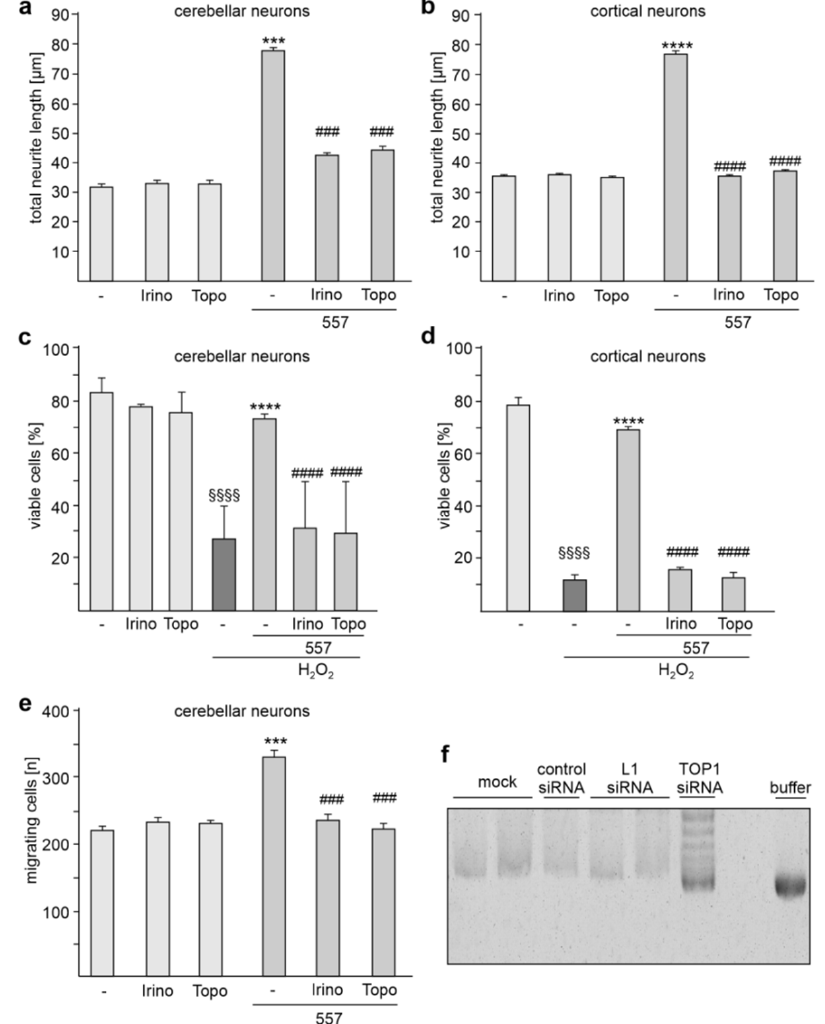
Figure 8. Topoisomerase inhibitors reduce L1-dependent neurite outgrowth as well as neuronal survival and migration. Cerebellar neurons ( a , c ) and cerebellar explants ( e ), and cortical neurons ( b , d ) were treated without (-) or with topotecan (Topo) or irinotecan (Irino) in the absence or presence of L1 antibody 557. ( a , b ) Mean values + SEM from three independent experiments are shown for total neurite lengths (*** p < 0.005, **** p < 0.001 relative to non-stimulated neurons in the absence of inhibitors, ### p < 0.005, #### p < 0.001 relative to stimulated neurons in the absence of inhibitors; one-way ANOVA with Dunn’s multiple comparison test). ( c , d ) Mean values + SEM from three independent experiments are shown for the numbers of viable cells relative to control (values of unstimulated neurons in the absence of H 2 O 2 set to 100%) (#### p < 0.0001 relative to stimulated neurons in absence of inhibitors and the presence of H 2 O 2 , **** p < 0.0001 relative to non-stimulated neurons in absence of inhibitors and the presence of H 2 O 2 , §§§§ p < 0.0001 relative to non-stimulated neurons in absence of inhibitors and H 2 O 2 ; one-way ANOVA with Dunn’s multiple comparison test). ( e ) Mean values + SEM from three independent experiments are shown for the total numbers of migrating cells (### p < 0.005 relative to stimulated neurons in absence of inhibitors, *** p < 0.005 relative to non-stimulated neurons in absence of inhibitors; one-way ANOVA with Dunn’s multiple comparison test). ( f ) Nuclear extracts from cortical neurons transfected without (mock) or with control siRNA, L1 siRNA or TOP1 siRNA were incubated with supercoiled pUC19 plasmid DNA. For control, the vector was incubated with the reaction buffer. The samples were then subjected to agarose gel electrophoresis and ethidium bromide staining. A representative image of a stained gel is shown.